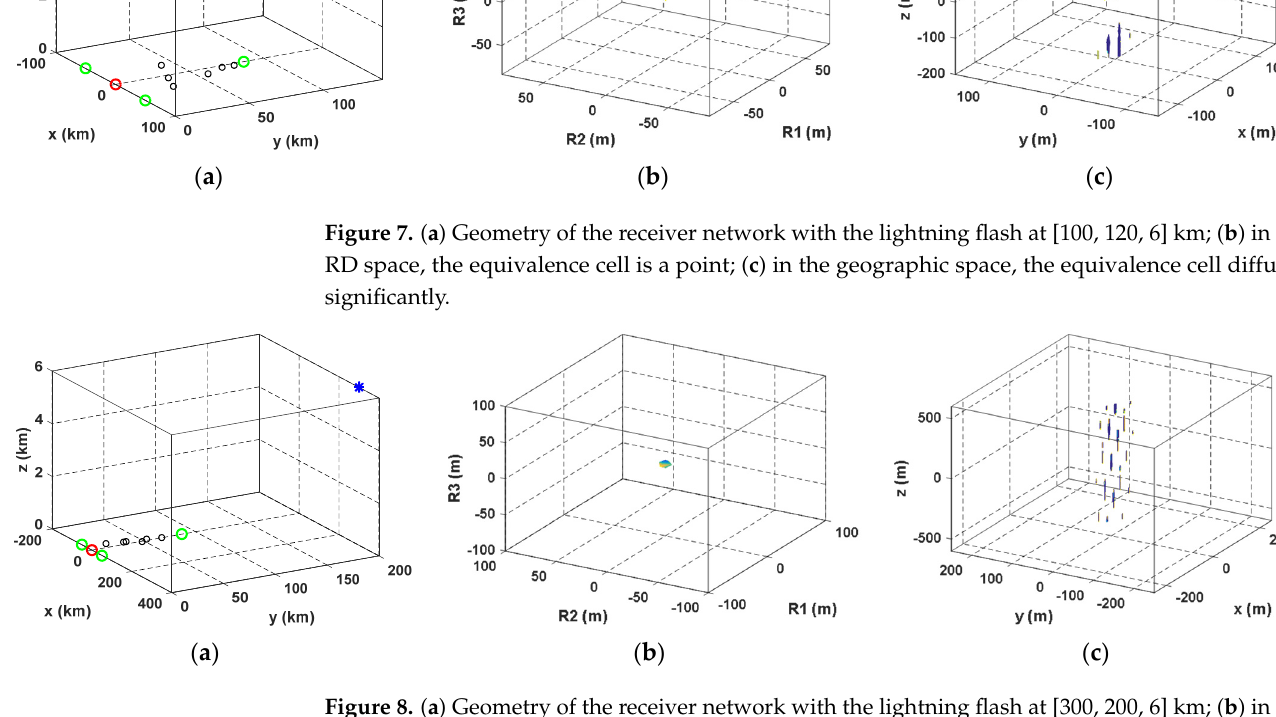
Figure 8. ( a ) Geometry of the receiver network with the lightning flash at [300, 200, 6] km; ( b ) in the RD space, the equivalence cell is a point; ( c ) in the geographic space, the equivalence cell diffuses in a mass region.